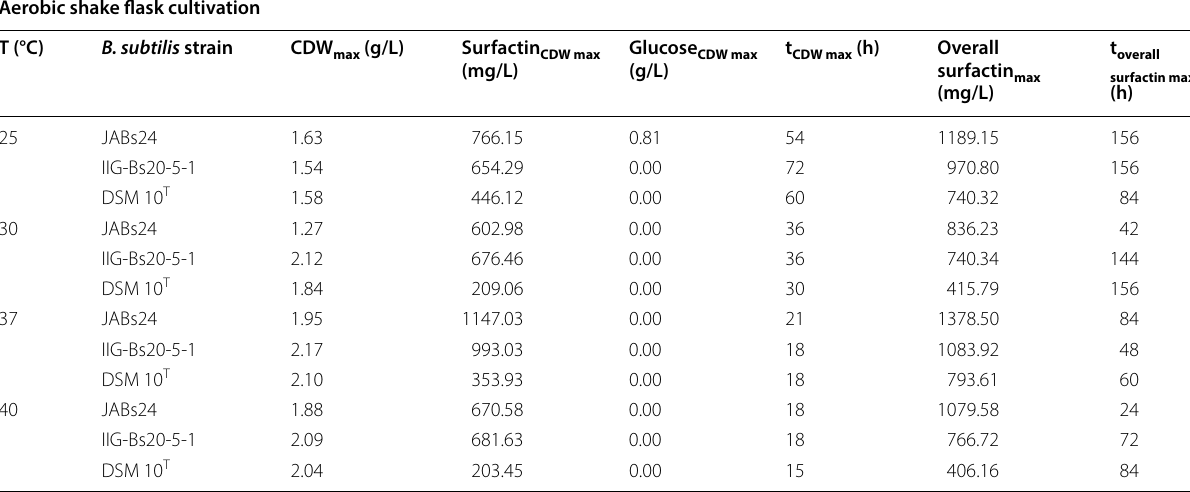
Table 2 Summary of the results obtained for aerobic cultivations at various temperatures Aerobic shake flask cultivation